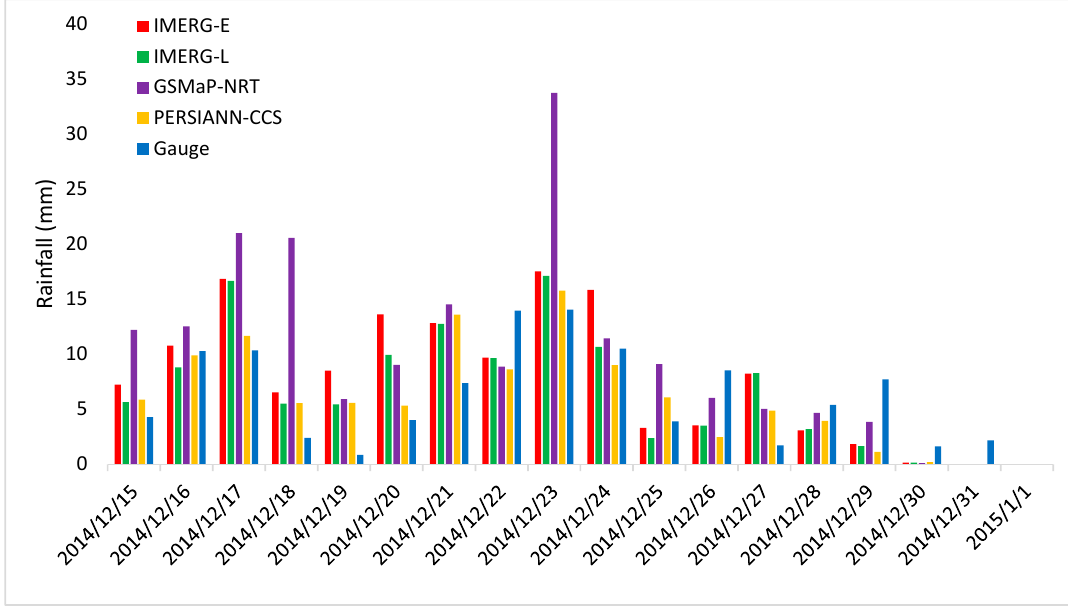
Figure 4. Comparison of averaged upstream daily rainfall of different rainfall estimates.